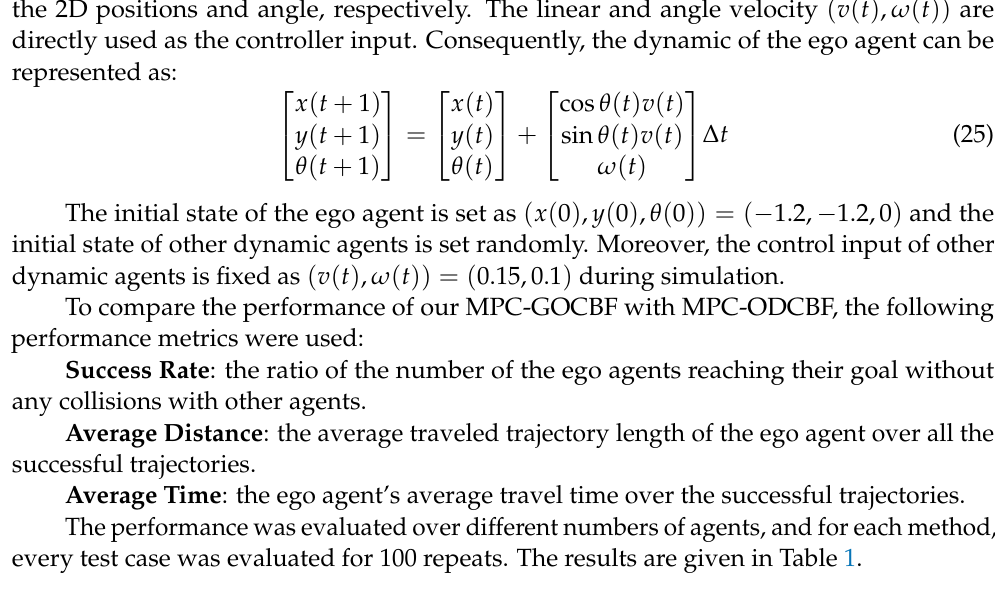
Table 1. Performance Metrics (As Mean/Std) Evaluated for MPC-ODCBF and our MPC-GOCBF with